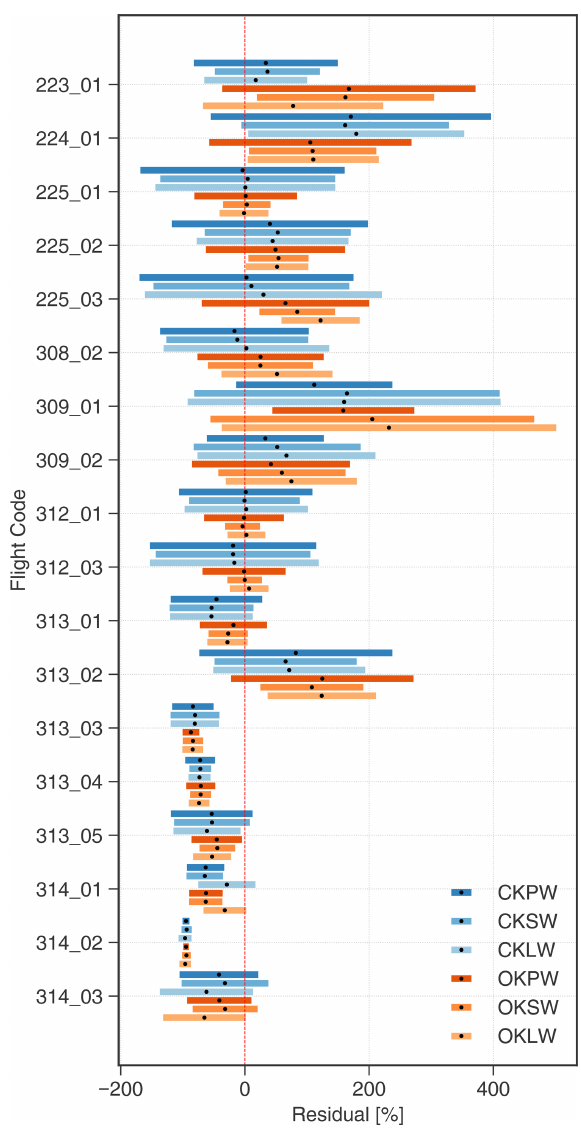
Figure 7. Residual plot. Colour-coded solid bars represent the range of residuals using different quantification approaches, with the mean values represented as black dots. Values to the right of the red line correspond to overestimations, and values to the left cor- respond to underestimations. CK and OK stand for cluster kriging and ordinary kriging, respectively. PW (projected wind), SW (scalar wind), and LW (logarithmic wind) refer to the different wind data